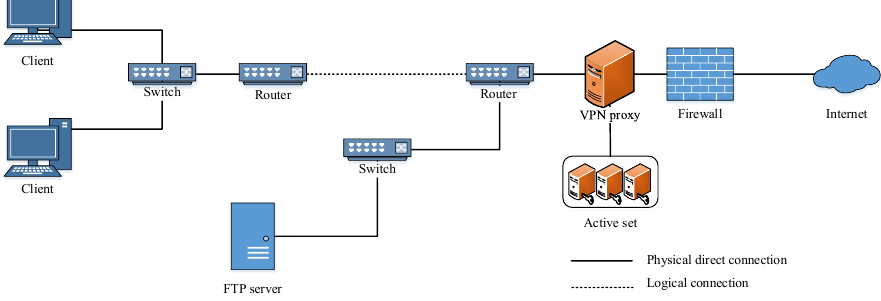
Figure 12. Description of the real experimental environment.